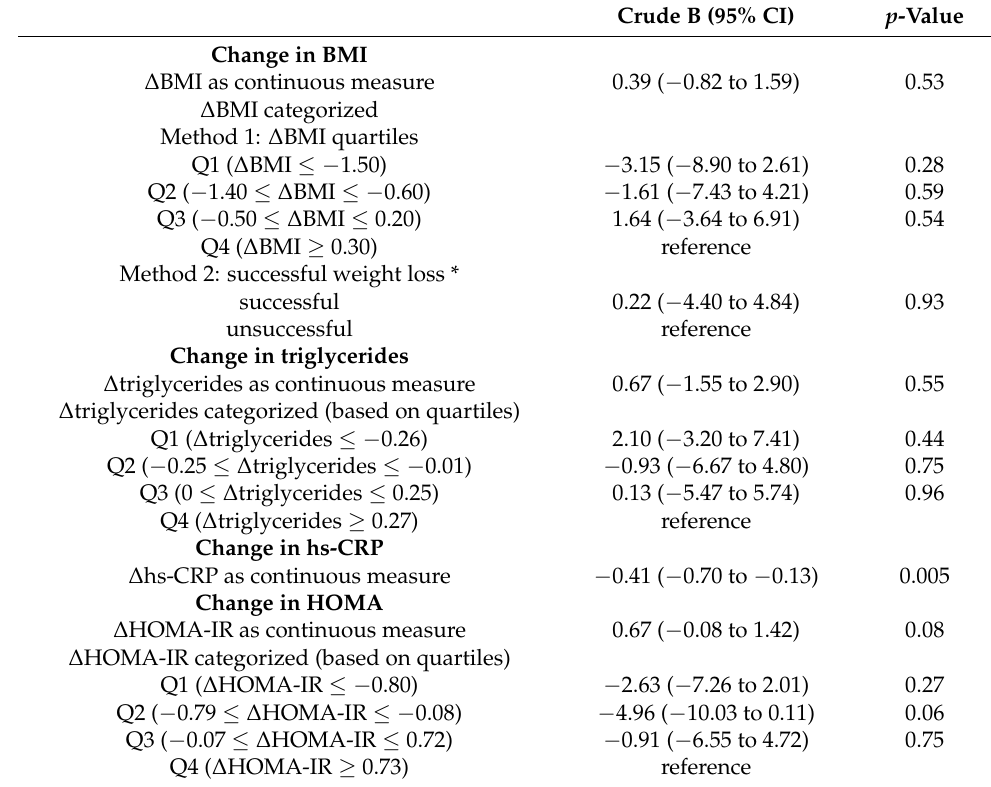
Table 4. Associations between baseline-corrected ˆ serum FT ( µ M) and ∆ BMI, ∆ triglycerides, ∆ hs- CRP and ∆ HOMA-IR (three